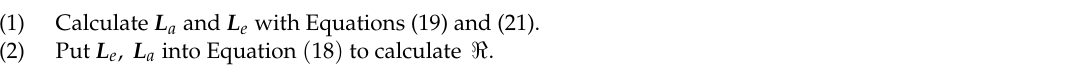
Table 1. Systematic Implementation of the Proposed 1D-MUSIC.